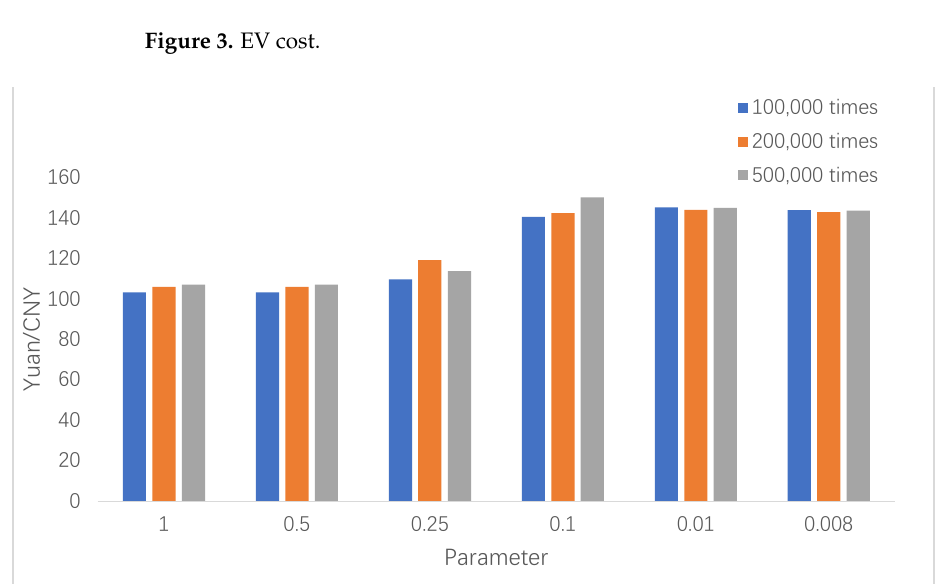
Figure 4. EV profit.